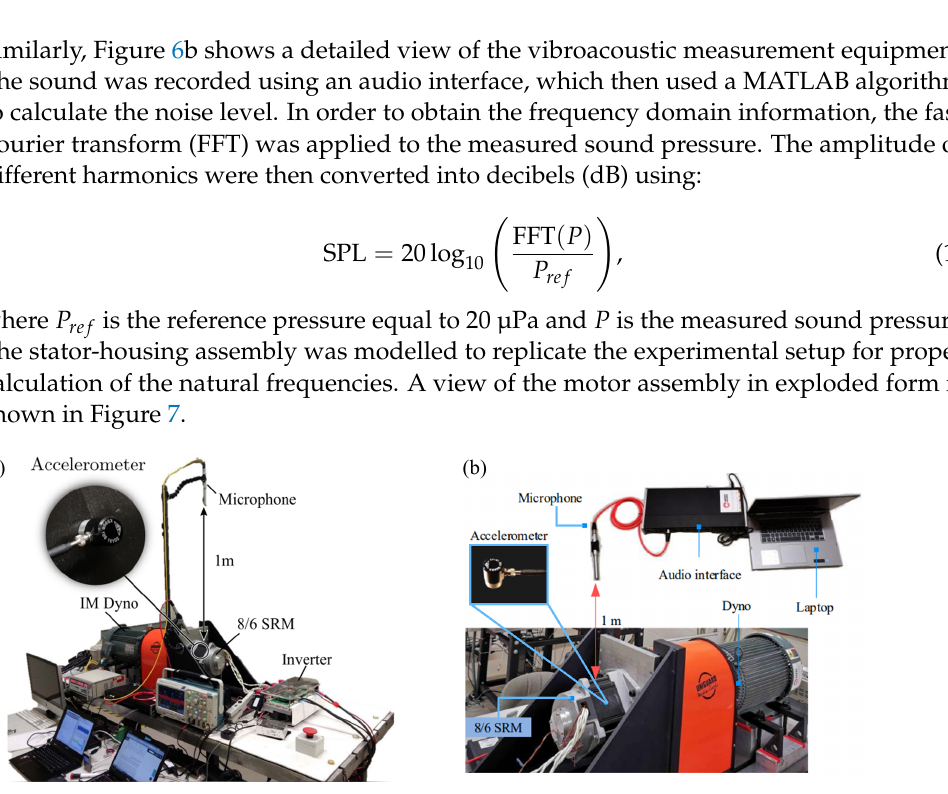
Figure 6. Experimental setup: ( a ) four-phase 8/6 SRM and ( b ) vibroacoustic measurement equipment.